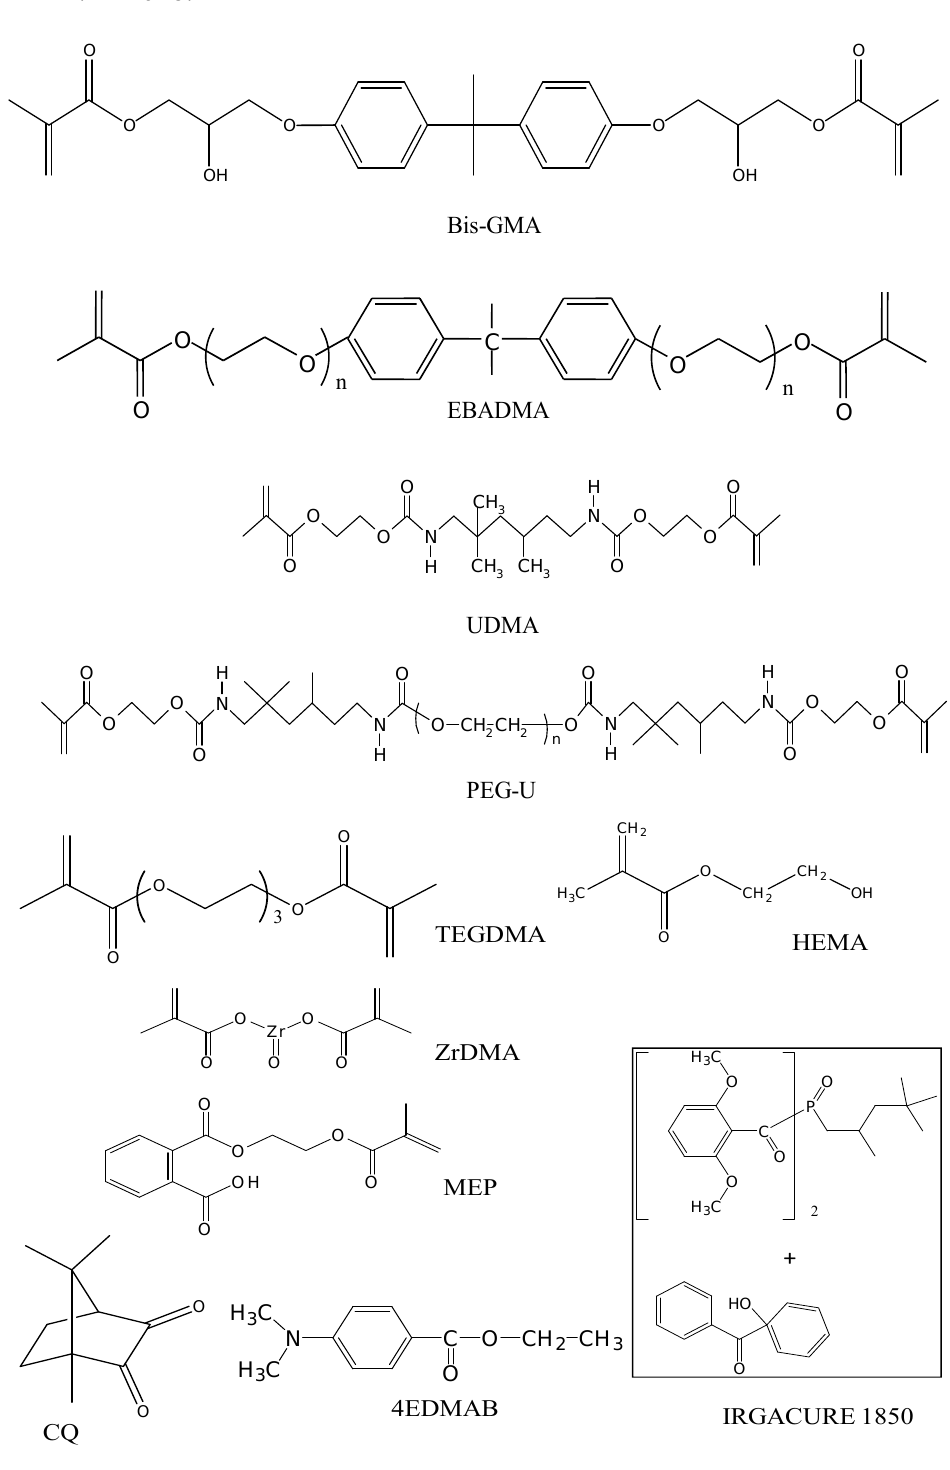
Figure 5. Chemical structure of monomers and photo-initiating systems used in the study. EBPADMA: n =